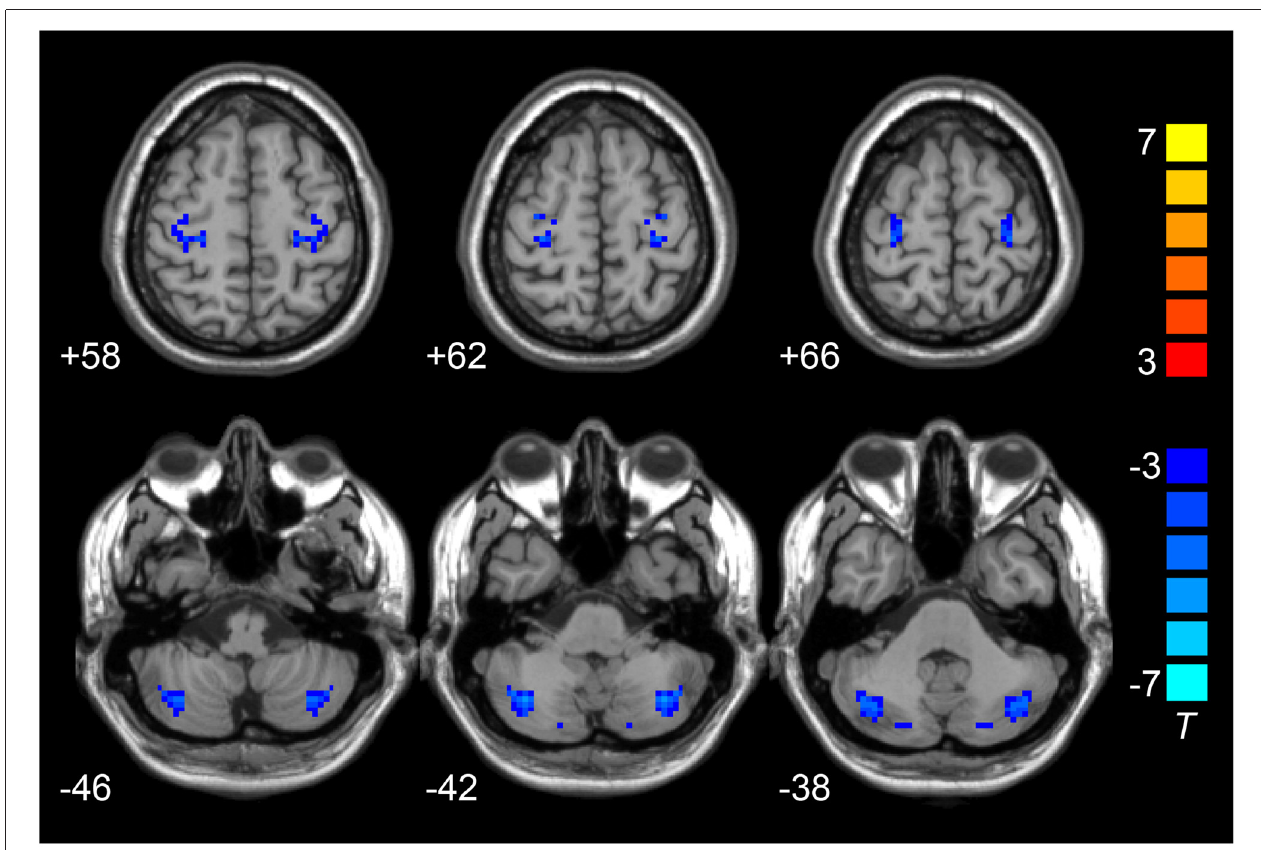
FIGURE 2 | Results of split-half sample validation. Comparisons of VMHC were analyzed between 16 LOD and 18 HCs. Blue color represents reduced VMHC value in LOD. The numbers at the down left of each image refer to the z -coordinates in Montreal Neurological Institute template. The threshold was set at a corrected P < 0.001 (corrected with P < 0.01 for each voxel and cluster volume ≥ 55 voxels) and the t -score bar is present at the right-side. Notes: HCs, Healthy Controls; VMHC, Voxel-Mirrored Homotopic Connectivity; LOD, Late-Onset